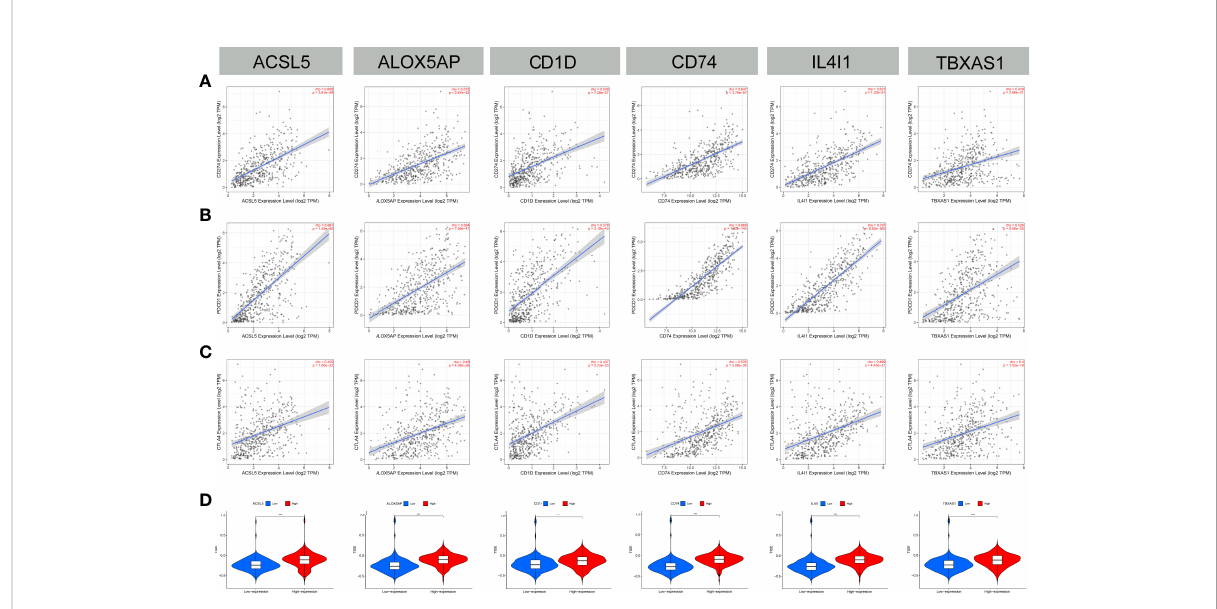
FIGURE 10 Immune checkpoint correlation and TIDE score. (A – C) The expression of the 6 FAMGs (ACSL5, ALOX5AP, CD1D, CD74, IL4I1 and TBXAS1) and that of immune checkpoints (PD-L1, PD-1, and CTLA-4) were signi fi cantly positively correlated. (D) The TIDE scores of the groups with high or low expression levels of the FAMGs showed that the high-expression group had worse immunotherapy responses. ***P ≤ 0.001.